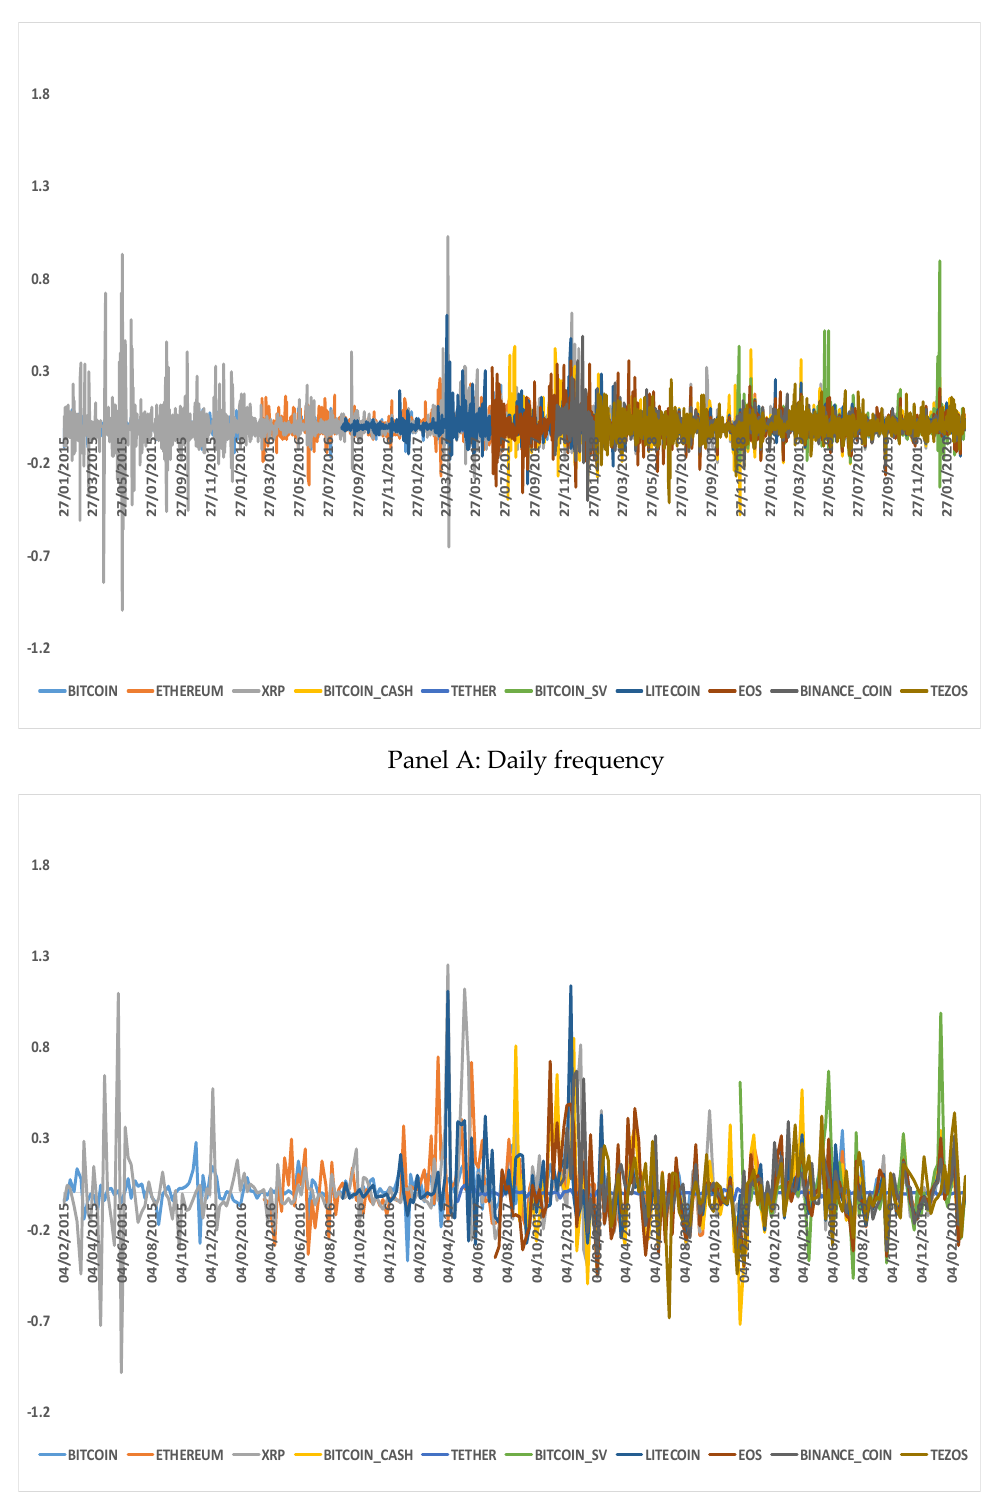
Panel B: Weekly frequency Figure 2.